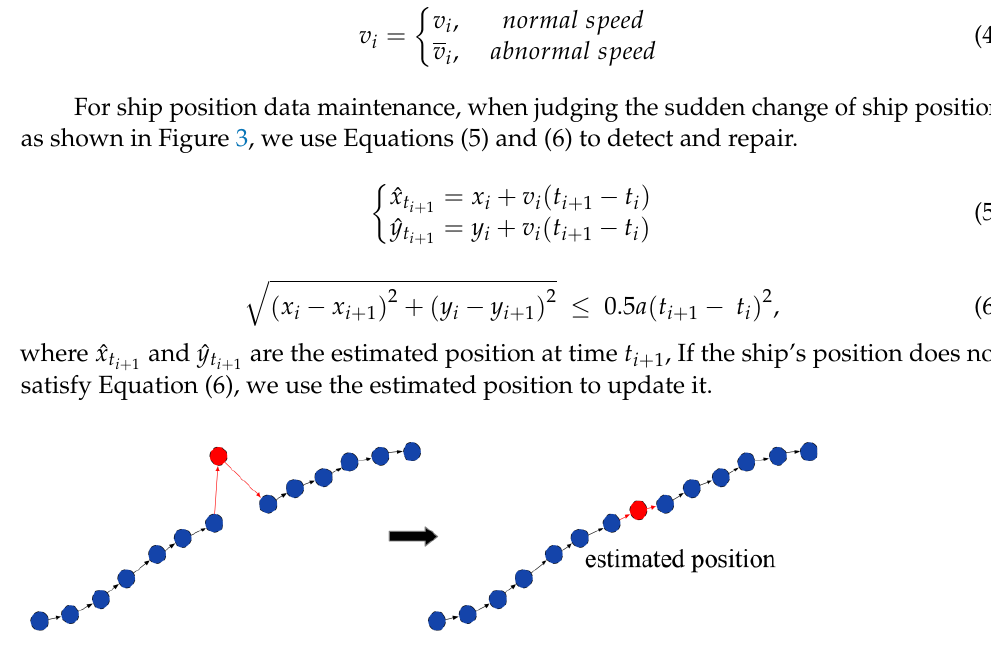
Figure 3. Trajectory point position anomaly repair effect.